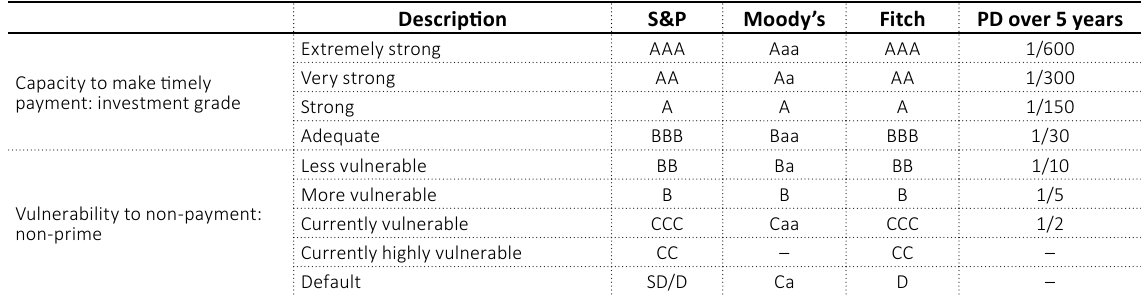
Table 1. Total default probability for each rating